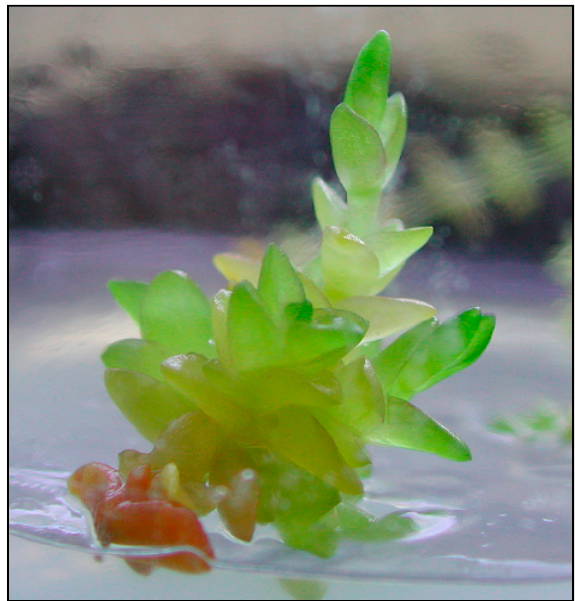
Figure 5. Top explant with symptoms of hyperhydicity regenerated on the Murashige and Skoog (MS) medium supplemented with 2 mg ∙ dm − 3 of 6-benzylaminopurine (BAP).